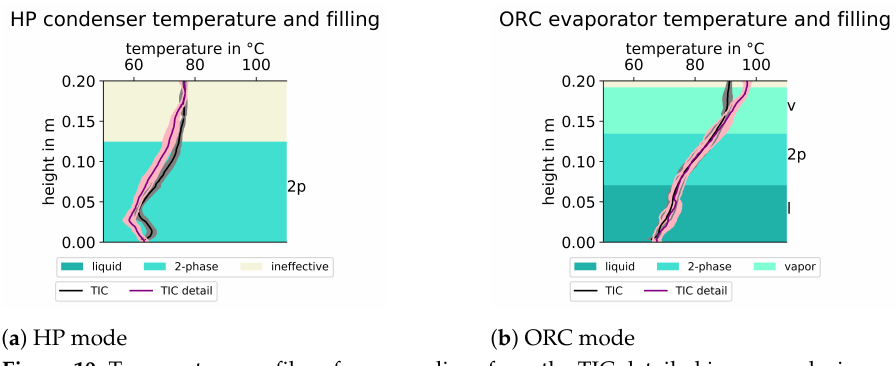
Figure 10. Temperature profiles of measure lines from the TIC detailed image analysis.